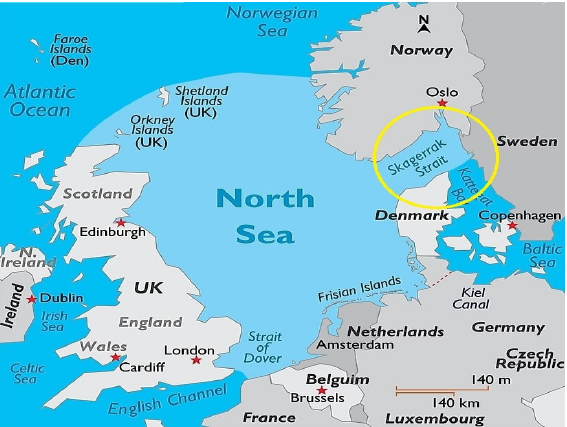
Figure 1. The North-Baltic ocean meeting scenario near to Skegen in Denmark [13], (All copyright issues are persevered by Valnet Inc. Adapted with permission from Editor in chief © 2022 worldatlas. com, accessed on 15 December